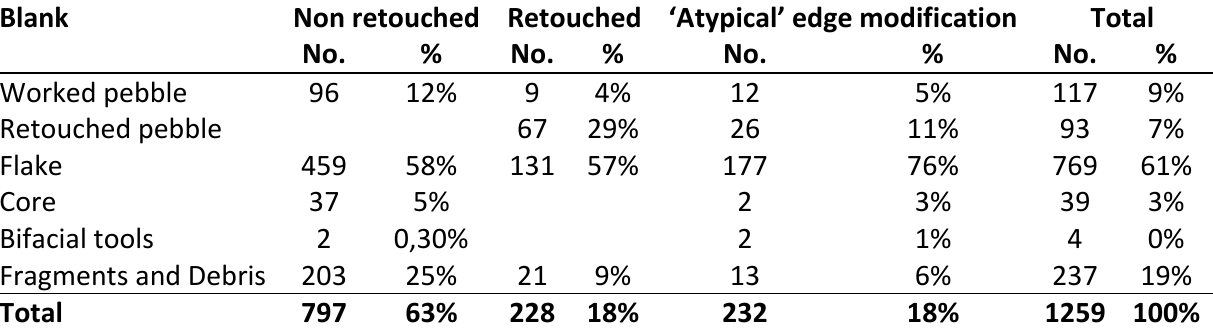
Table 5. Total number and percentages of Non retouched, retouched and “atypical” retouch of the lithic